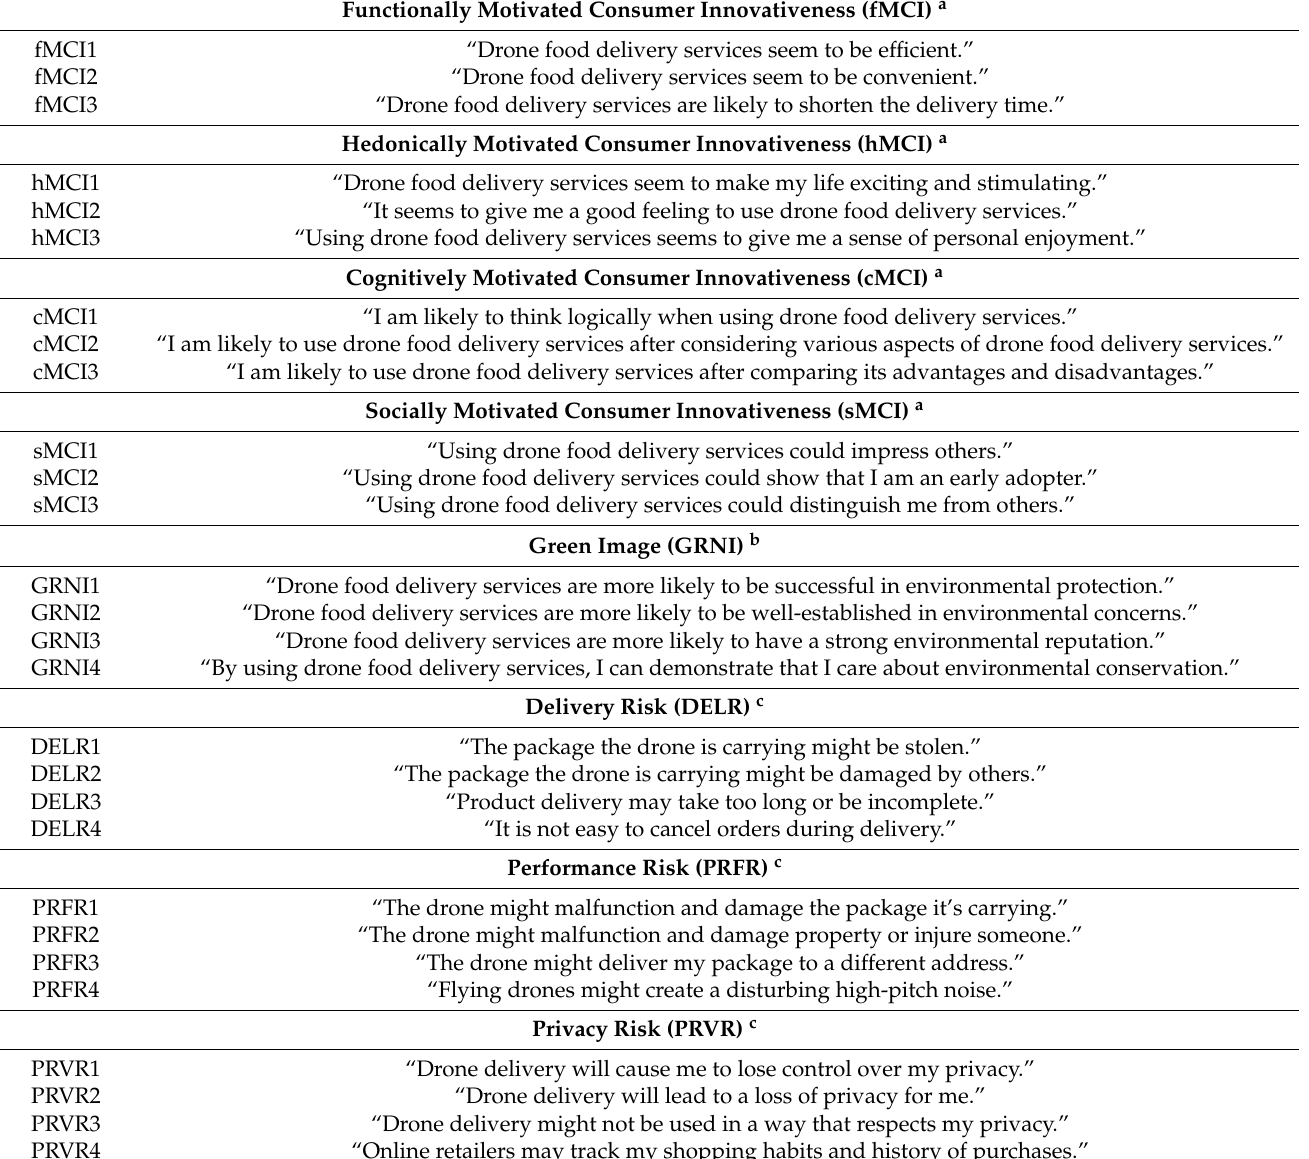
Table 1. Research